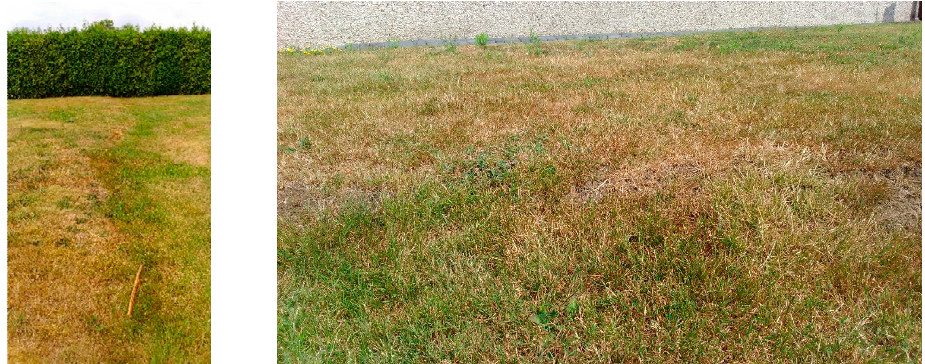
Figure 4. Discontinuous linear deformation (a ground step) with a value of fault 0.2 m towards the south.